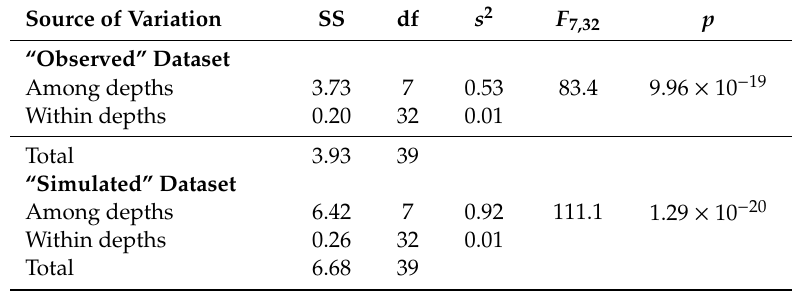
Figure 6. Results of principal component analysis on the “observed” dataset (67 species × 40 samples) ( a , c ) and on the “simulated” dataset (66 species × 40 samples) ( b , d ). Panels a and b illustrate the percentage of the total variance explained by each axis (component), with 95% bootstrapped confidence intervals (error bars); the red curves represent the eigenvalues expected under a broken-stick random model. Sample points in c and d are indicated by their depth (in m), while the convex hulls visualize the multivariate dispersion of the points, with axes being always drawn at the same scale. Table 3. Results of one-way analysis of variance on the first axis scores of depth-points in PCA plots for both the “observed” and the “simulated” datasets.